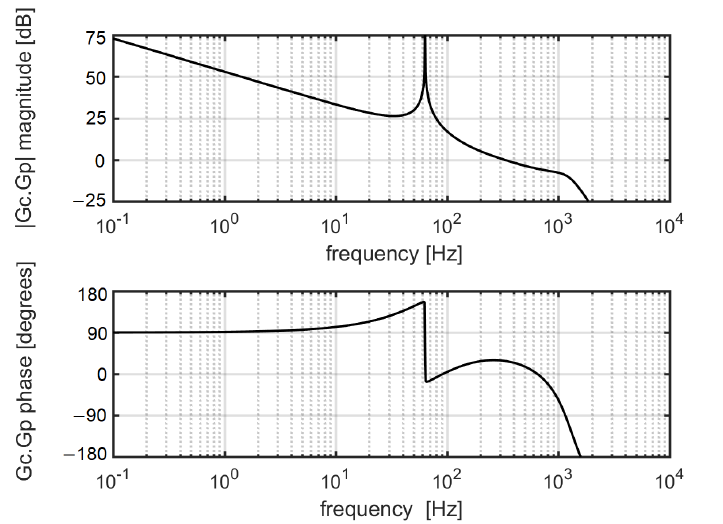
Figure 6. Stability simulation of an electrostatically-driven harmonic oscillator (with transfer function G p (32)) controlled by a discrete active disturbance rejection controller (ADRC; transfer function G c (37)). In the graph, the magnitude and phase of product G c . G p are plotted. The sampling frequency was chosen to be f s = 80kHz. The controller and observer bandwidth were chosen to be 200 π and 2000 π rad/s, respectively. A sinc-window FIR filter with 50 delay registers and a cutoff frequency of 1kHz was introduced in both deflection and force path to the state